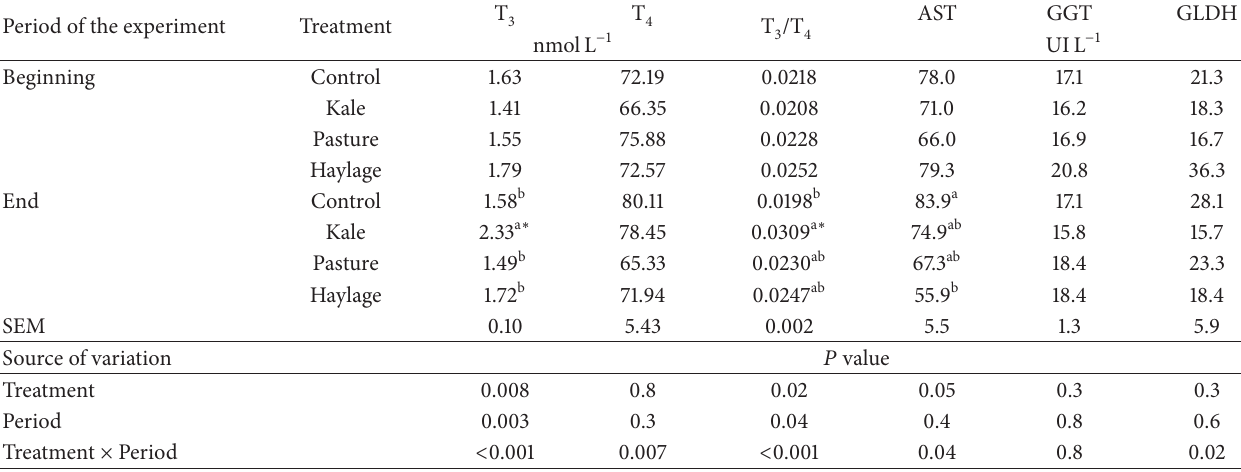
Table 2: Blood thyroid hormones (T , triiodothyronine, and T , thyroxine) and hepatic enzymes (AST, aspartate aminotransferase; GGT, 3 4 gamma-glutamyl transferase, and GLDH, glutamate dehydrogenase) at the beginning and the end of the experiment for calves fed a control hay diet with 1kg of barley daily (Control), a 50% kale/50% haylage based diet (Kale), a management intensive grazing (Pasture), or a grass haylage based diet